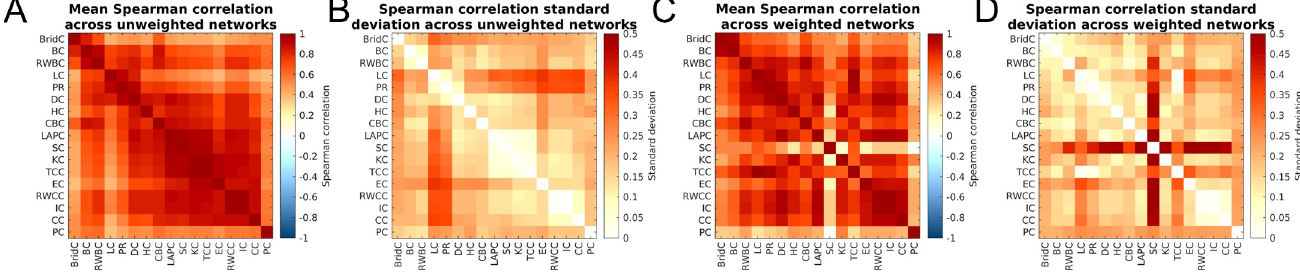
Fig 3. Mean and standard deviation of between-network CMCs. Panels A and B show the between-network CMC mean and standard deviation for unweighted measures, respectively. Panels C and D show the between-network CMCs mean and standard deviation for weighted measures, respectively.